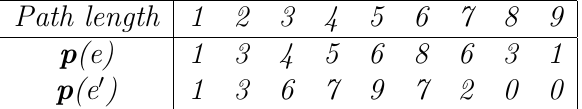
Table 8 : Path-vectors for edges 𝑒 and 𝑒 ′ in tree 𝑇 ∗